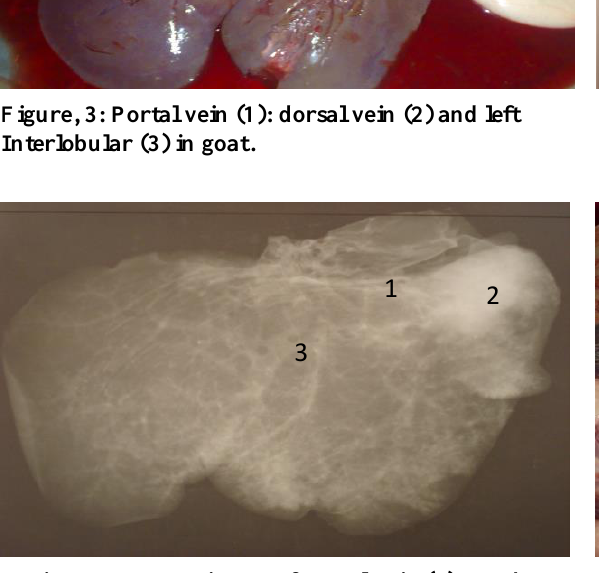
Figure, 5:X-Ray image of portal vein (1); caudate (2) and quadrate(3) in goat.